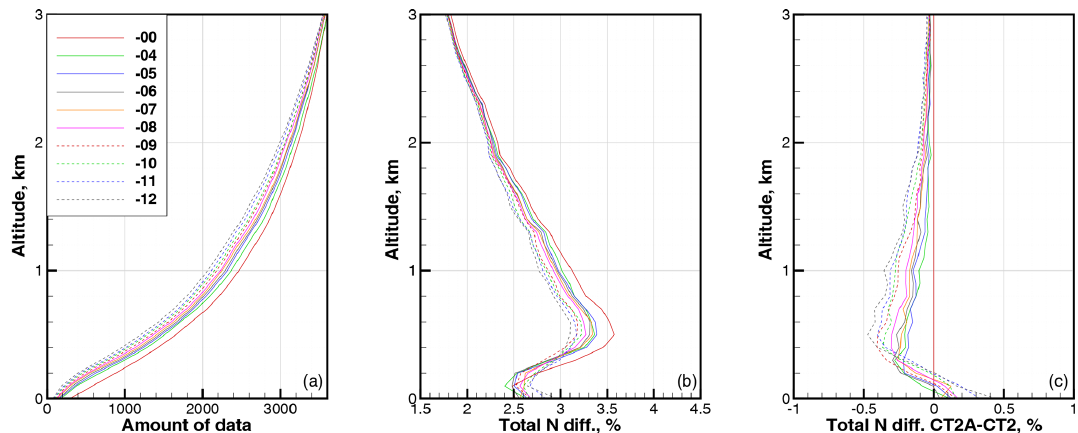
Figure 13. Statistics for latitude band 10–20 ◦ evaluated for subsets common for β = 0 and each other value of β . (a) Amount of data. (b) RMS relative difference in refractivity COSMIC–ECMWF (cid:49)N CE . (c) RMS relative difference in refractivity CT2A–CT2. All are functions of the parameter β